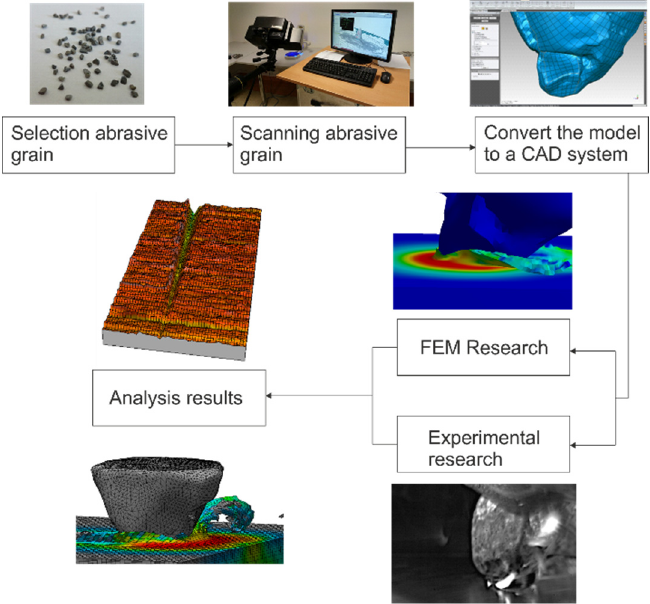
Figure 1. Scheme of the research method of the microcutting process with a single abrasive grain.